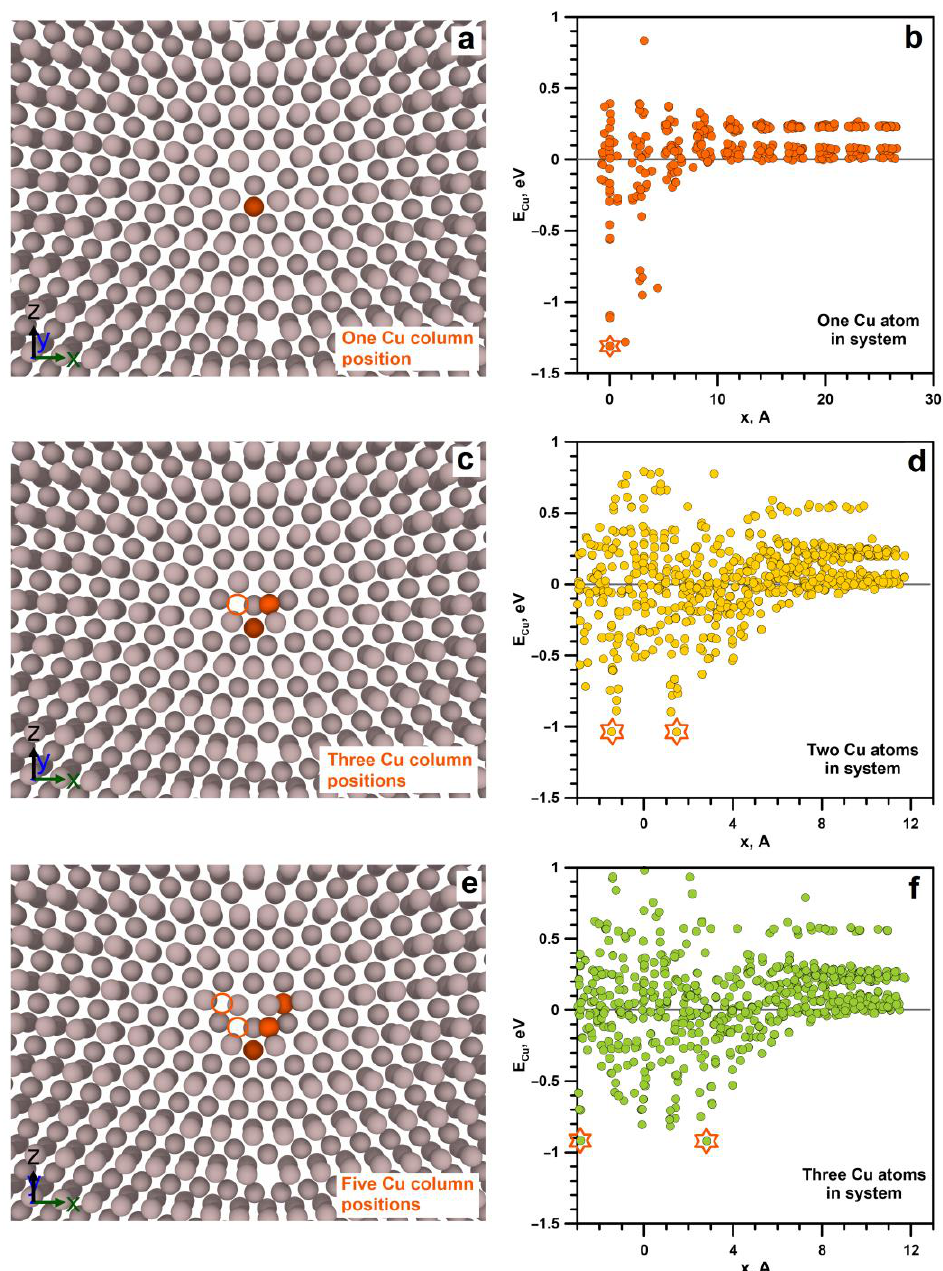
Figure 2. ( a , c , e ) Positions of Cu atoms at GB. The filled orange circles correspond to the Cu atom with the calculated minimal energy; the contour orange circles are symmetrical with respect to GB reflections of the calculated positions of the Cu atoms. Grey circles are Al atoms. ( b , d , f ) Dependencies of energy on the Cu atom position in the system near GB after energy minimization. The asterisks indicate the minimum energy of Cu atoms in the system by which the Cu atom positions at GB are determined. All positions of Cu atom are plotted in the xz -plane. x = 0 corresponds to Cu atom position at GB void